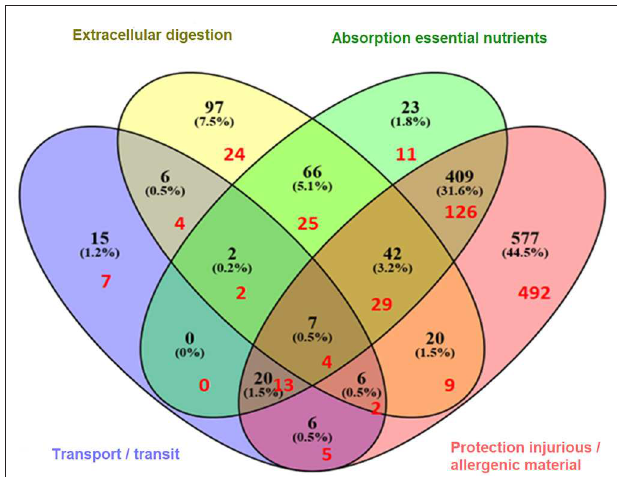
FIGURE 2 | Venn diagram illustrating the (shared) sets of molecules involved in gut function-related processes: extracellular digestion ingested material, supply essential nutrients, transport/transit of ingested material, and protection from injurious or allergenic material (number of genes in black). In red are indicated the number of genes that are predicted to be shared with immune related diseases (hypersensitivity, autoimmunity, resistance to infection, and cancer) as previously described (11).